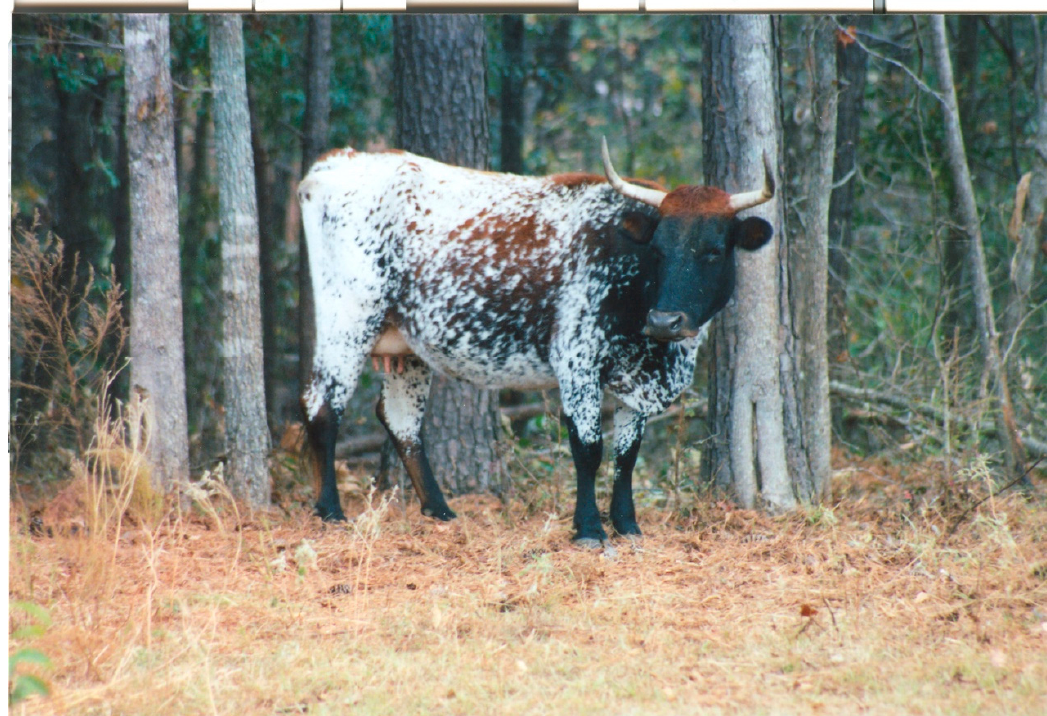
Figure 4. Pineywoods cow of the Conway line, with a variation from Virgil Berry’s herd. Photo by D.P. Sponenberg.